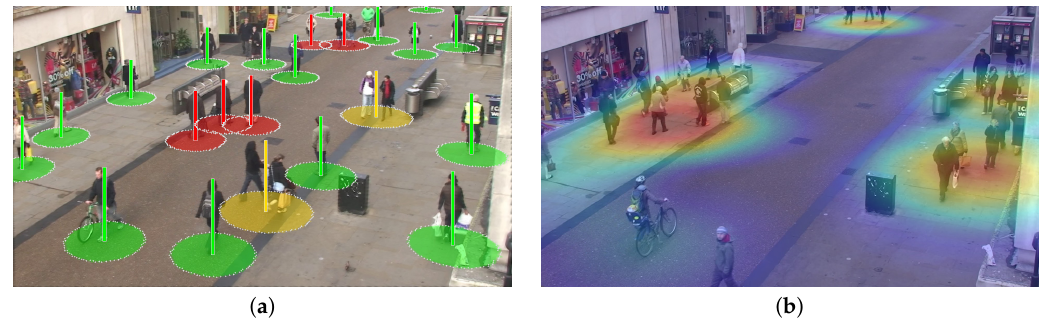
Figure 1. People detection, tracking, and risk assessment in Oxford Town Centre, using a public CCTV camera. ( a ) Social distancing monitoring; ( b ) Accumulated infection risk (red zones) due to breaches of the